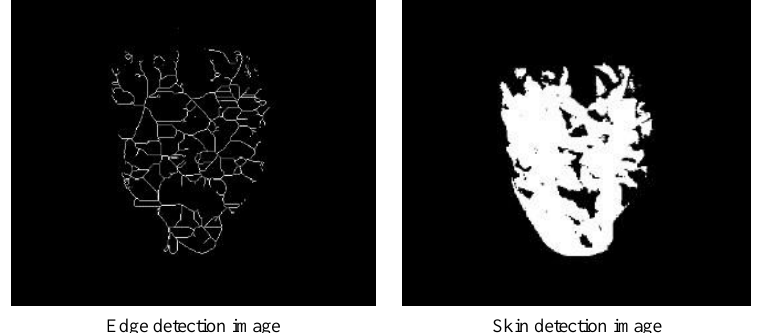
Figure 6. Detection the skin effected